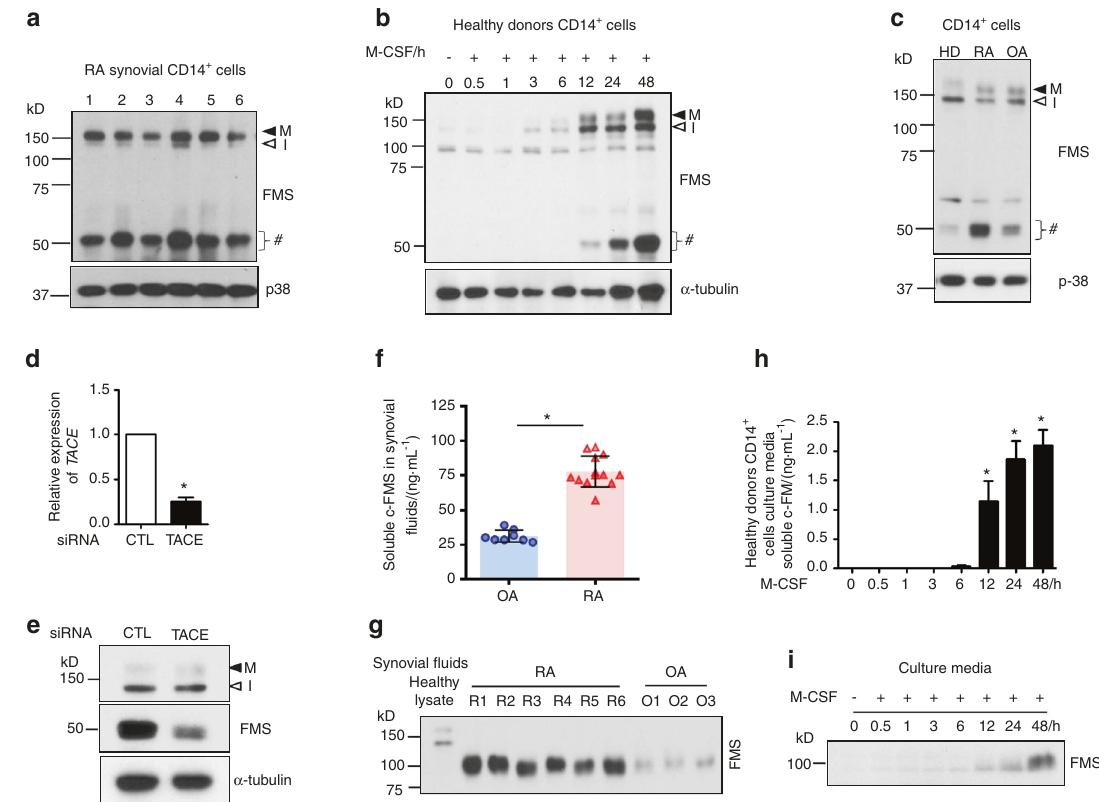
Fig. 1 The detection of small fragments of c-FMS and soluble c-FMS. a Immunoblot analysis of rheumatoid arthritis (RA) synovial CD14 + cells with antibodies against the C-terminus of c-FMS. b Human CD14 + cells from healthy donors were cultured with M-CSF for the indicated times. Immunoblot analysis of whole cell lysates with antibodies against the C-terminus of c-FMS. c Immunoblot analysis of whole cell lysates from CD14 + cells from healthy donors cultured with M-CSF for 1 day (HD) and synovial CD14 + cells from patients with RA or osteoarthritis (OA). d , e Human CD14 + cells were nucleofected with control (CTL) or TACE siRNAs and then cultured with M-CSF. d Knockdown (KD) ef fi ciency. TACE mRNA was measured by qPCR and normalized to HPRT. e Immunoblot analysis of KD cells using an anti-c-FMS antibody. f , g Soluble c-FMS levels in synovial fl uids from patients with rheumatoid arthritis (RA, n = 13) and osteoarthritis (OA, n = 8) were measured by ELISA ( f ) and immunoblot analysis with antibodies against N-terminal c-FMS ( g ). h , i Human CD14 + cells were cultured with M-CSF. Soluble c-FMS in the culture media was measured by ELISA ( h ) and immunoblot analysis with anti-c-FMS antibodies ( i ). All data are shown as the mean ± SEM. * P < 0.05 by unpaired t -test ( d , f ) or one-way ANOVA with a post hoc Tukey test ( h ). The data represent at least 3 independent donors. M; a mature c-FMS, I; an immature c-FMS, #; small fragments. c-FMS proteolysis accelerates RANKL-induced osteoclast differen- (DAP5, also known as eIF4G2). In contrast to the well-known tiation and arthritic bone erosion. Our results also provide a strong function of eIF4G1, the role of DAP5 in protein translation is basis for a new therapeutic target for pathological bone controversial. A recent study showed that DAP5 could form resorption in RA. inactive complexes and suppress protein translation 18 . Another study revealed that the DAP5 complex promoted alternative translation of speci fi c subsets of mRNAs 19 . Furthermore, the full RESULTS function of the DAP5 complex has not been de fi ned, and the role Synovial CD14 + cells show a distinct c-FMS expression pattern of DAP5 in myeloid cells is unknown. We showed that ligand engagement of c-FMS generated FMS M-CSF/c-FMS signaling is implicated in the pathogenesis of RA. intracellular domain (FICD) fragments in both human and murine Consistent with a previous report showing increased M-CSF macrophages via proteolysis. Here, we showed that increased expression in RA synovial fl uids 5 , M-CSF levels were signi fi cantly FICD protein levels in arthritic synovial macrophages promoted higher in RA synovial fl uids than in osteoarthritis (OA) synovial fl uids (Supplementary Fig. 1a). We also measured the expression osteoclast differentiation and arthritic bone erosion. Using gain-of- function and loss-of-function studies, we demonstrated that FICD of cell-associated c-FMS in synovial CD14 + cells from RA patients. fragments enhanced osteoclast differentiation and activity. A c-FMS antibody against the C-terminal region of the receptor Furthermore, myeloid-speci fi c FICD transgenic mice exhibited an detected mature, glycosylated c-FMS (150 kD, M) and immature, osteoporotic phenotype with increased osteoclasts and the unglycosylated c-FMS (130 kD, I), as expected. Intriguingly, we also promotion of arthritic bone erosion compared with those of detected small fragments of ~50 kD in synovial CD14 + cells using control mice. This positive role of the FICD in osteoclasts was anti-c-FMS antibodies (Fig. 1a). We next examined whether CD14 + mediated by accelerating MAP kinase-interacting serine/threo- cells from healthy donors expressed small fragments. Immunoblot nine-protein kinase 1 (MNK1/2) activation and NFATc1 expression analysis of freshly isolated CD14 + cells showed low levels of by binding to DAP5. Overall, our fi ndings elucidate the molecular mature and immature c-FMS, but small fragments were hardly mechanisms of c-FMS proteolysis in osteoclasts and reveal how detectable (Fig. 1b). After fresh CD14 + cells were cultured with Bone Research (2021)